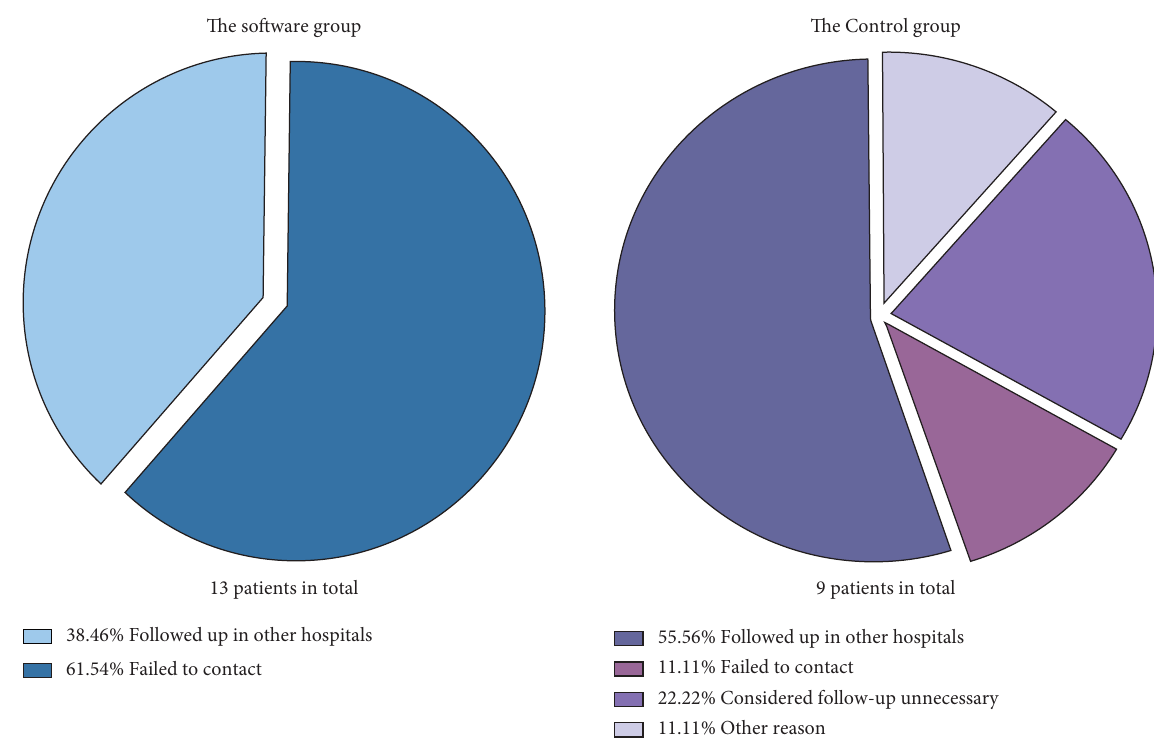
Figure 7: Pie diagram of the causes of participants lost to